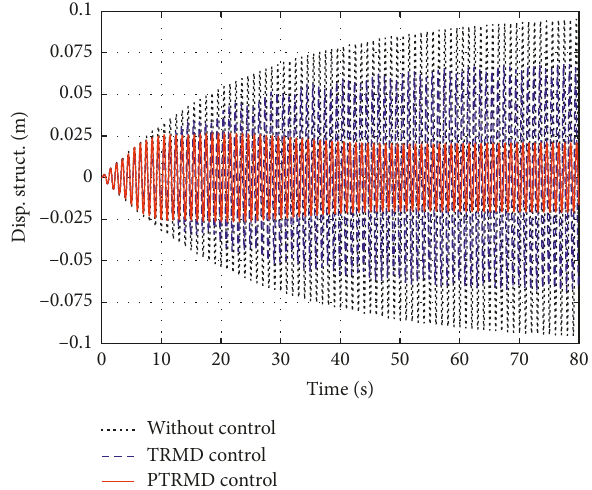
Figure 16: Response of the structure subjected to excitation of varied